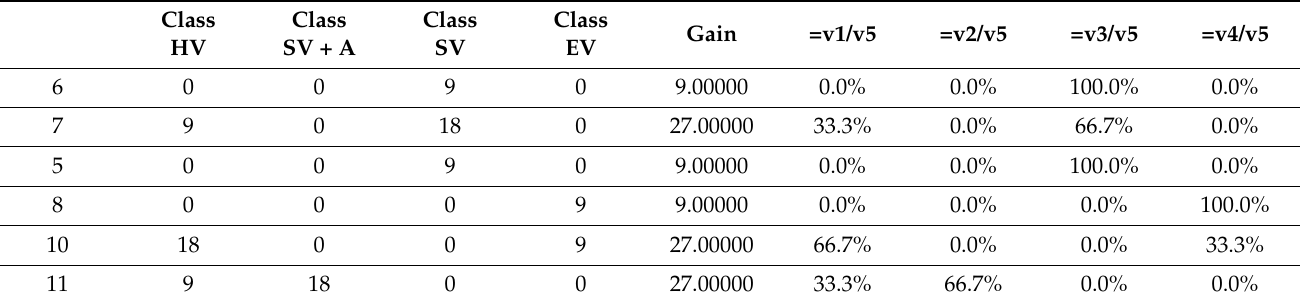
Table 2. Results in terminal nodes for the dependent variable: popularity of car type in the near future in the group of women. Model: C&RT.